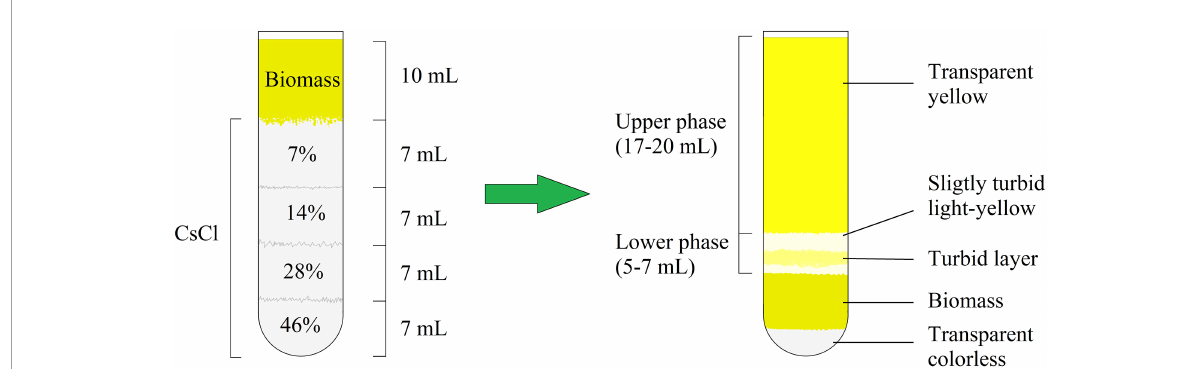
FIGURE1 CsCl gradient formation and biofilm matrix following extraction after 72 h of incubation.